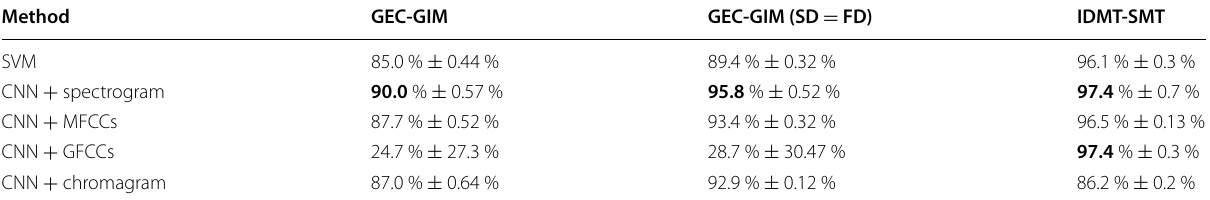
Table 3 95% confidence intervals for the classification accuracy of the convolutional neural network (CNN) using the listed time- frequency representations as well as the accuracy of the baseline support vector machine (SVM) using the method by Stein et al. [4]. As subsequent parameter extraction is not necessarily compromised by a confusion of slapback delay (SD) and feedback delay (FD), the respective accuracies, when SD and FD are treated as the same effect, are given as